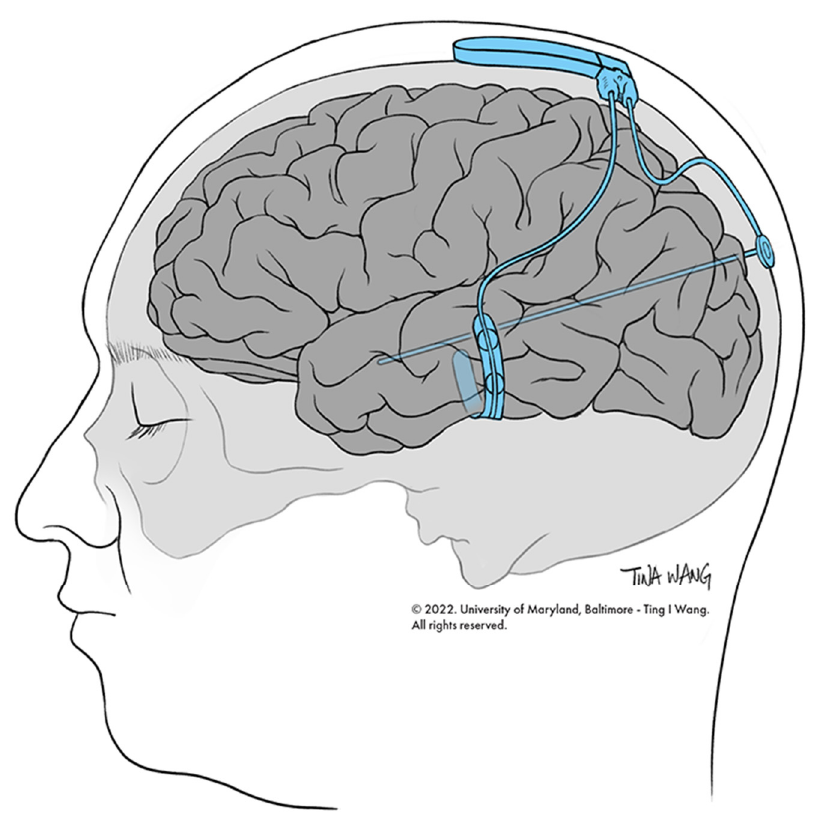
Figure 1. RNS system. Representation of implanted RNS system.